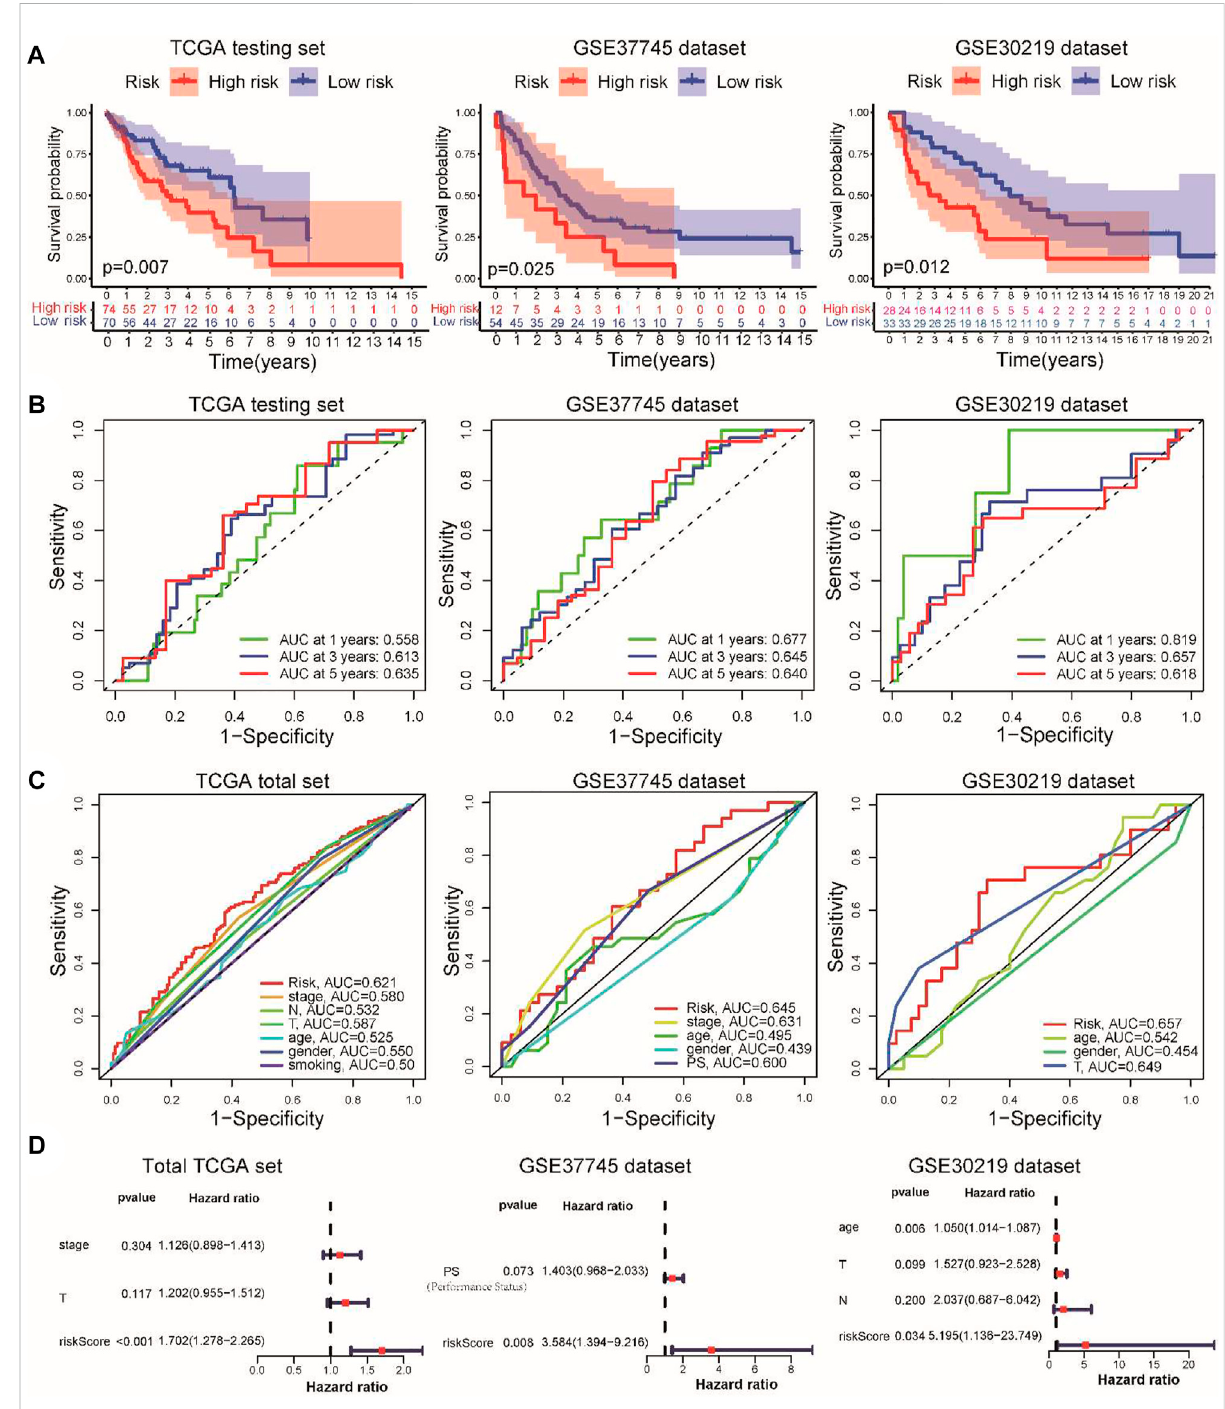
FIGURE 2 Validation of the prognostic signature in TCGA internal testing and GEO external datasets. (A) Kaplan – Meier survival analysis of overall survival between the high- and low-risk groups in the validation datasets. (B) Time-dependent ROC for 1-, 3-, and 5-year OS predictions for the prognostic signature in validation datasets. (C) Time-dependent ROC curves for clinical characteristics and risk score for 3-year OS of LUSC in TCGA set and GEO datasets. (D) Multivariate Cox regression analyses of the risk score in the total TCGA cohort and GSE37745 and GSE30219 external validation